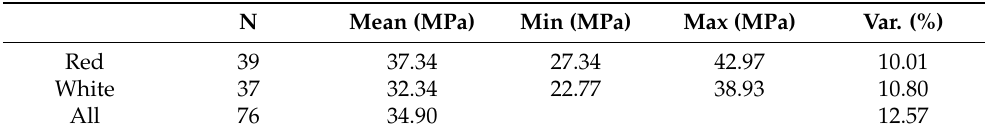
Table 2. Results of compression test of grape